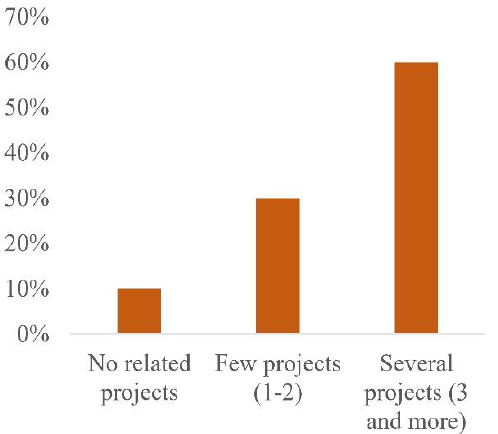
Figure 3. Industry 4.0 implementation level in Kazakhstan companies.